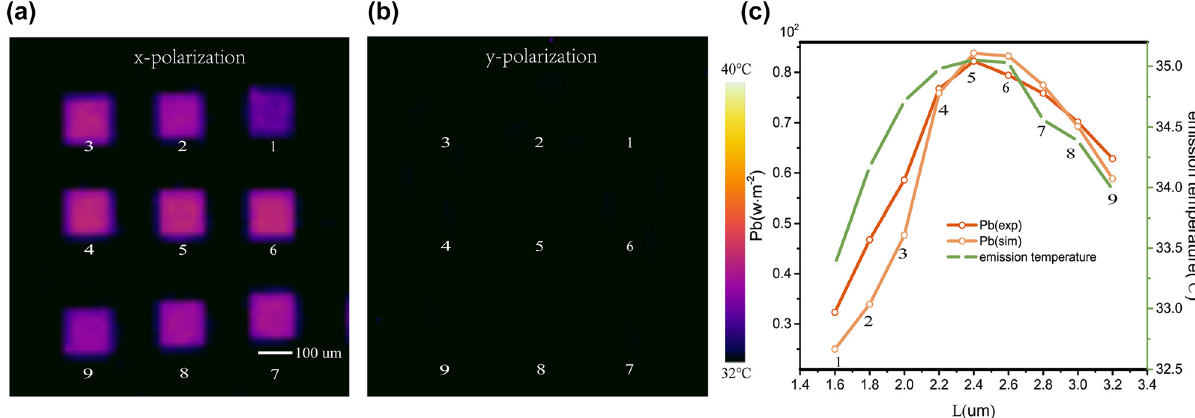
Figure 2: Thermal images of meta-cavity array based thermal emission microchip. The thermal images taken under x polarizer (a) and y polarizer (b) after heating the sample to 100 ◦ C. (c) Calculated thermal radiation energy Pb each meta-cavity structure under x